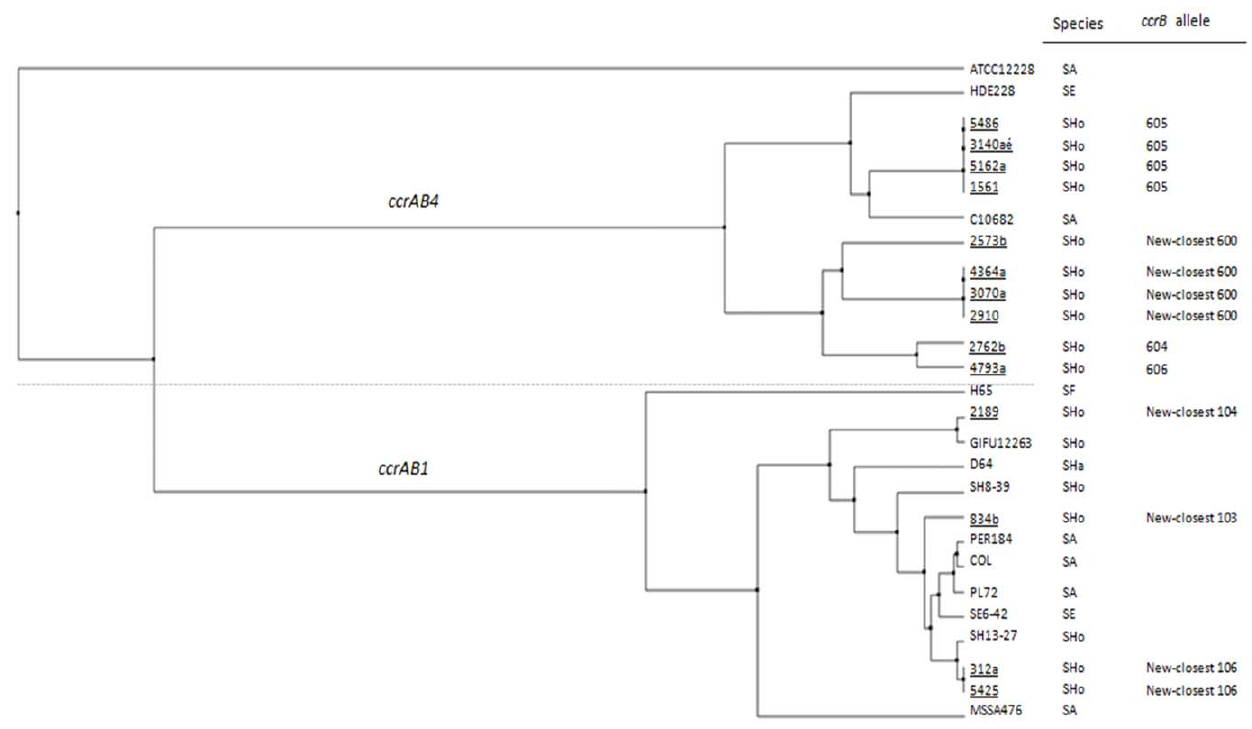
Figure 2. Phylogram (average distance) using the identity percentage for ccrB 1 and ccrB 4 carried by S.hominis isolates and ccrB prototype sequences available on 17 June 2010 at the ‘ ccrB typing tool’ online resource. The tree was automatically drawn by the Java applet available through the ‘ ccrB typing tool’ using the default parameters [14]. MRSHo and MSSHo isolates from this study are underlined. Control isolates were the following by order of appearance from top to bottom: ATCC12228, Methicillin-susceptible S. epidermidis (MSSE) strain; carrying the SCC pbp4 ; HDE288, methicillin-resistant S. aureus (MRSA), carrying SCC mec VI; C10682, MRSA carrying SCC mec type VIII; H65, S. fleuretti isolate from database carrying ccrAB4 from ccrB typing tool database; GIFU1223, MSSHo strain GIFU1223 (ATCC27844), carrying the SCC 1223 ; SH-8-39, S. hominis isolate carrying ccrAB1 from the database; D64, S. haemolyticus isolate carrying ccrAB1 from the database; PER184, MRSA, carrying SCC mec I; COL, MRSA carrying SCC mec I; PL72, MRSA carrying SCC mec I; SE6-42, S. epidermidis isolate from the database, carrying ccrAB1 ; SH13-27, S. hominis from the database carrying ccrAB1 ; MSSA476, methicillin-susceptible S. aureus (MSSA), carrying SCC MSSA476 . SA, S. aureus ; SE, S. epidermidis ; SHo, S. hominis ; SHa, S. haemolyticus ; SF, S. fleuretti